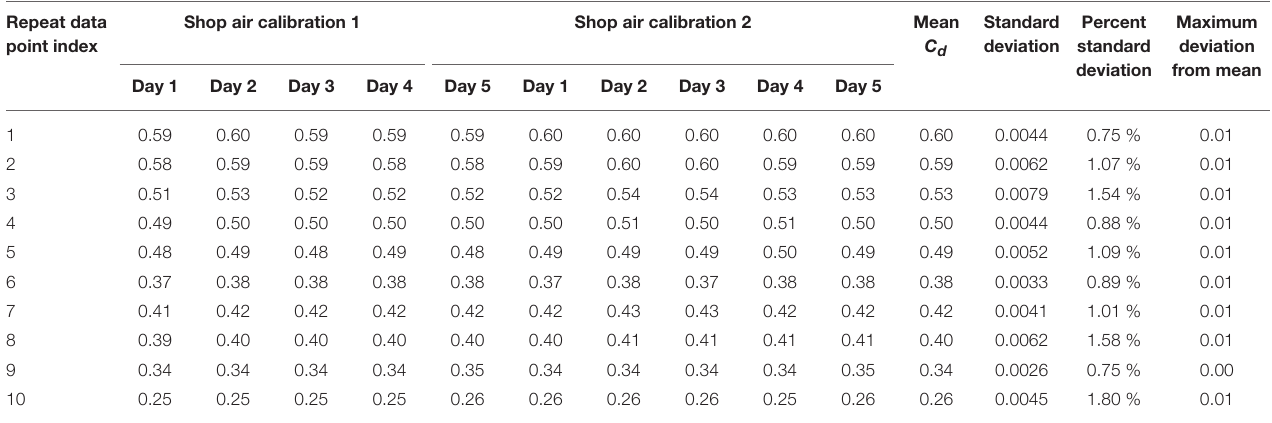
TABLE 3 | C d values for the 10 data points repeated 10 times over a month long period. Repeat data point